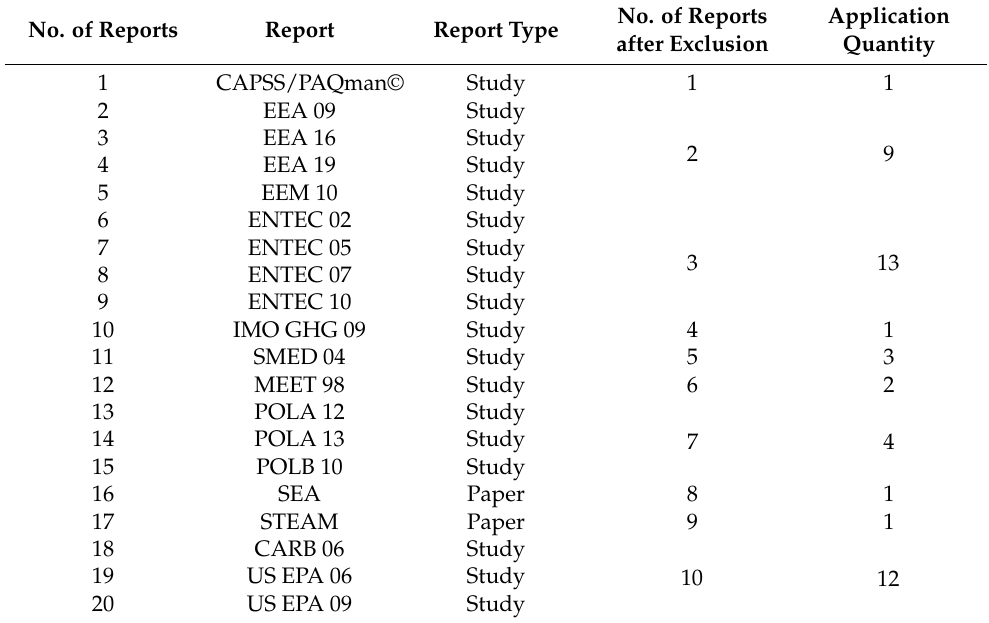
Table 3. Exclusion and application quantity of references based on